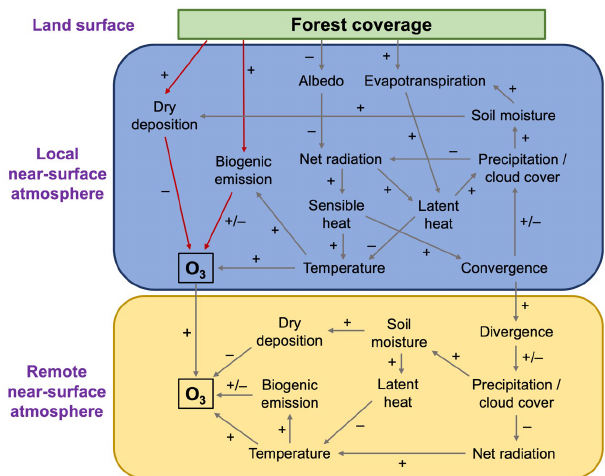
Figure 1. Schematic diagram showing the biogeochemical and bio- geophysical effects of any changes in the forest cover resulting from land use and land cover change (LULCC) on surface ozone. Red arrows indicate the biogeochemical pathways and grey arrows indi- cate the biogeophysical effects via changes in the overlying mete- orological environment. The sign associated with each arrow indi- cates the correlation between the two variables; the sign of the over- all effect (positive or negative) of a given pathway is the product of all the signs along the pathway. We here focus on processes initiated on the land surface by LULCC and the corresponding responses in local near-surface atmosphere (blue box) and remote near-surface atmosphere (yellow